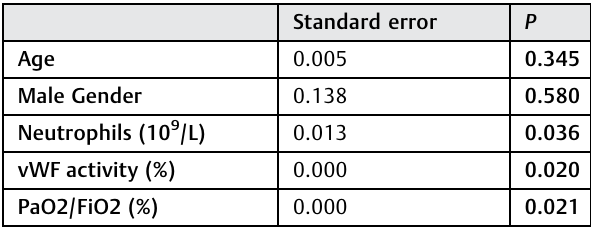
Table 3 Biomarker comparison between non-survivors and survivors COVID-19 patients